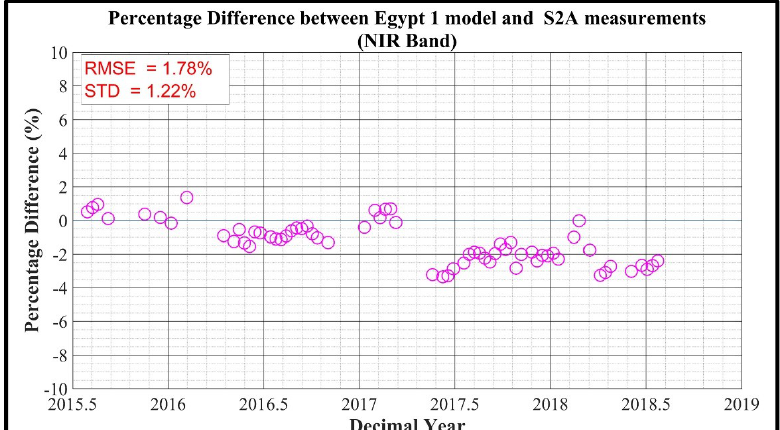
Figure 14 . Percentage Difference between S2A MSI measurements and model predictions. Remote Sens. 2019 , 11 , x FOR PEER REVIEW 15 of 21